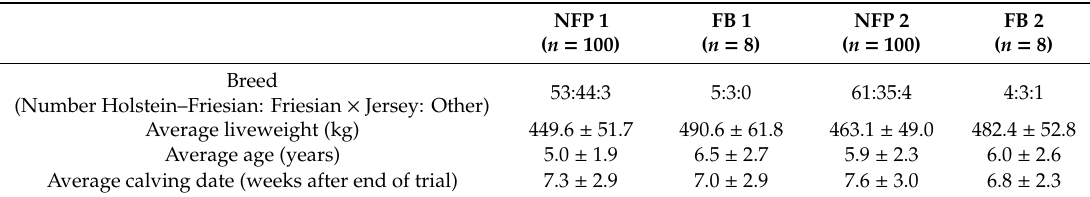
NFP 1 FB 1 NFP 2 ( n = 100) ( n = 8) ( n = 100)